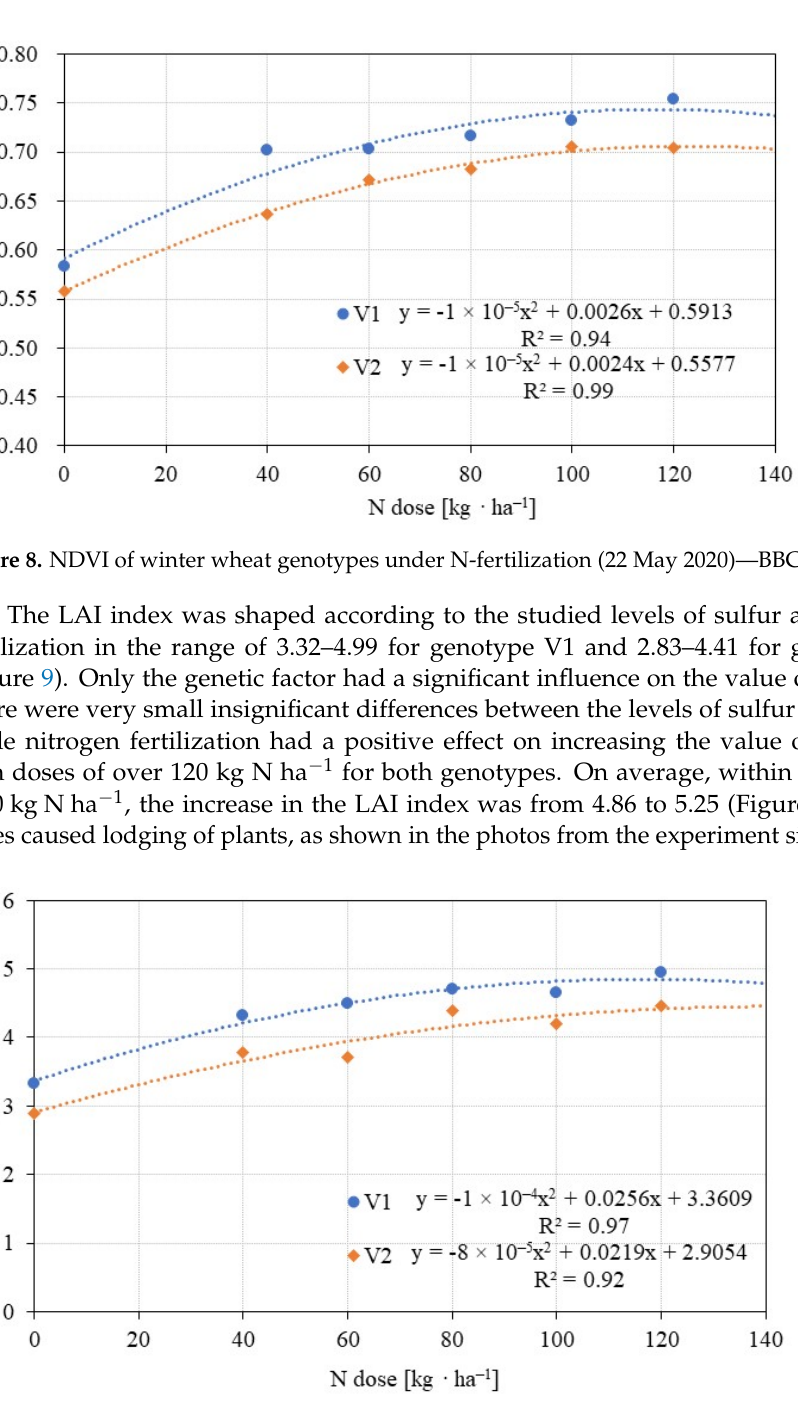
Figure 9. LAI of winter wheat genotypes under N-fertilization (22 May 2020)—BBCH 39. Table 5. CCCI of winter wheat genotypes under fertilization.